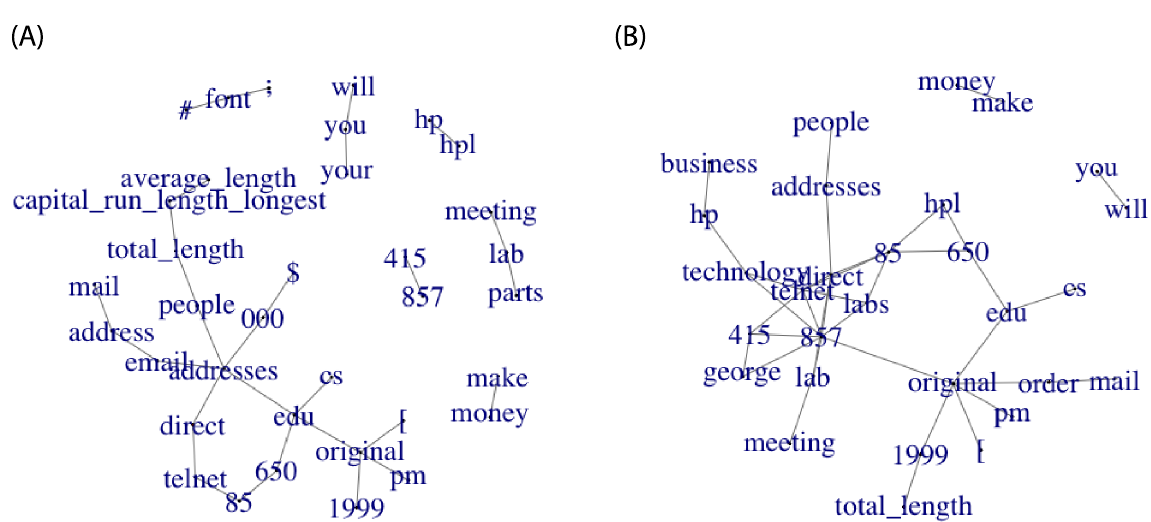
Fig 4. A comparison of the D-net and B-net DN estimates for the spam emails dataset. (a) The Bayesian DN for the spam emails dataset. (b) The iterative-shrinkage DN for the spam emails dataset.